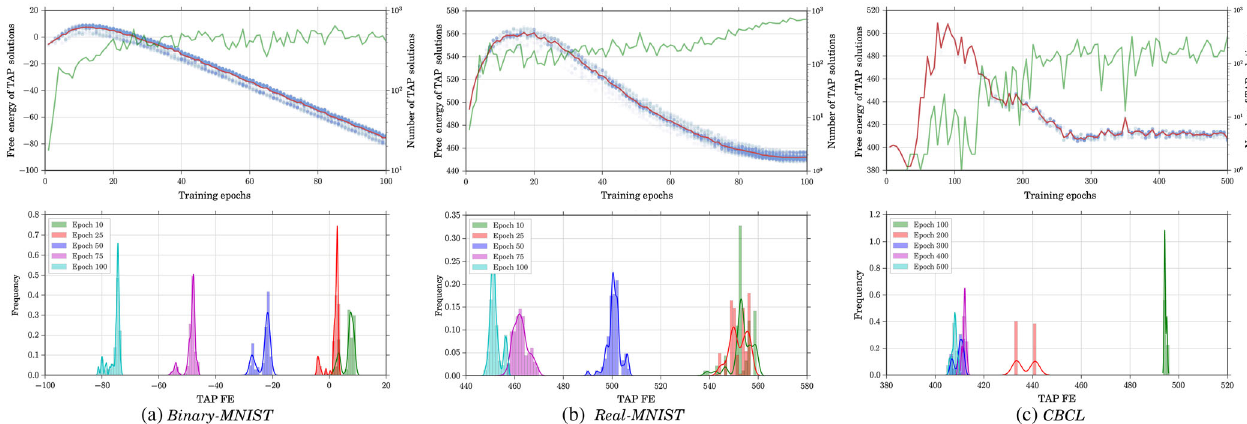
FIG. 5. Distribution of free-energy estimates of TAP solutions as a function of training epochs for the three different data sets. In the case of the two MNISTexperiments, the number of hidden units is the same. N h ¼ 100 and 10 000 samples drawn from the training data are used as initial conditions. For CBCL, 2400 training samples are used. Top row: TAP free energy for all unique TAP solutions (transparent blue dots) and the Helmholtz free energy estimate via uniform averaging (red line). The number of unique TAP solutions is also given (green line). Bottom row: Detail of TAP free-energy distributions for slices of training. Histograms are given as bars, while kernel density estimates of the TAP free-energy distribution are given as